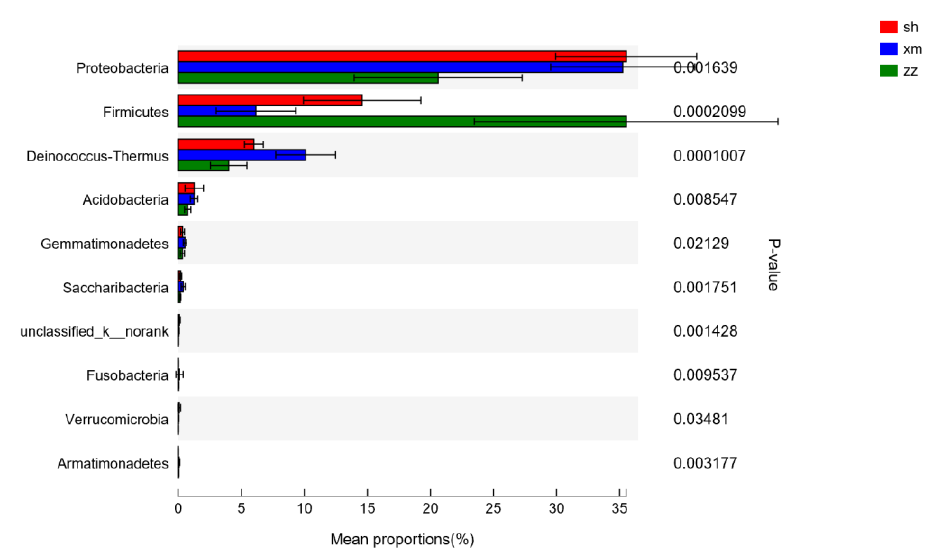
Figure 7. Bacteria flora difference check column at the phylum level. (sh: Shanghai; xm: Xiamen; zz: Zhangzhou).